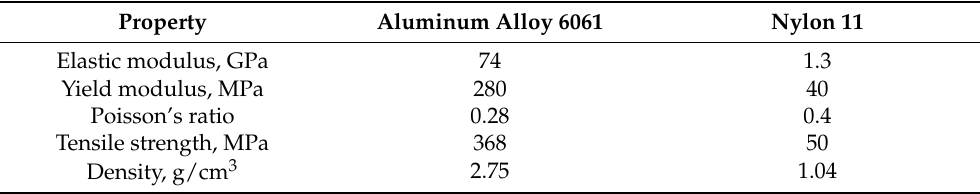
Table 2. The material parameters used for plastic liner and metal BOSS.